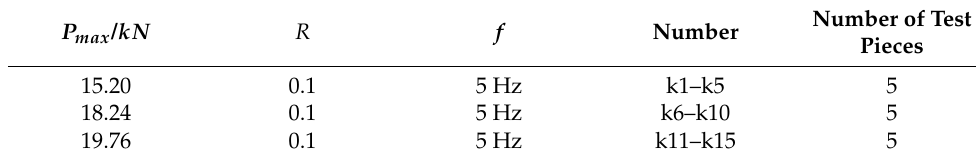
Table 2. Fatigue test plan for single-detail perforated plates. P max / kN